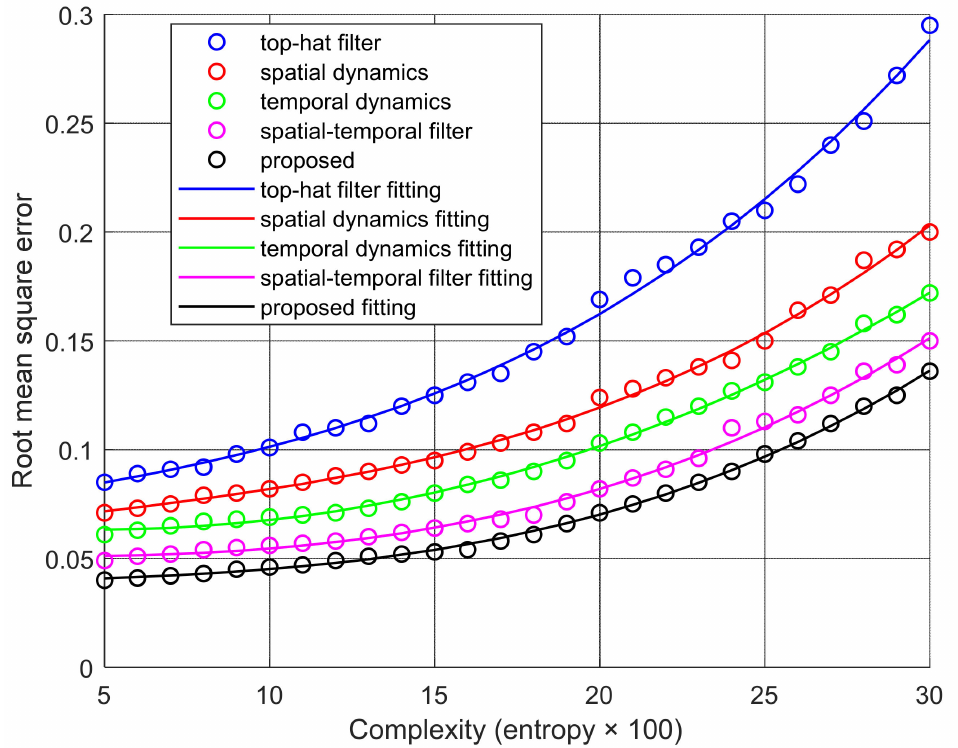
Figure 16. Estimation error versus sea